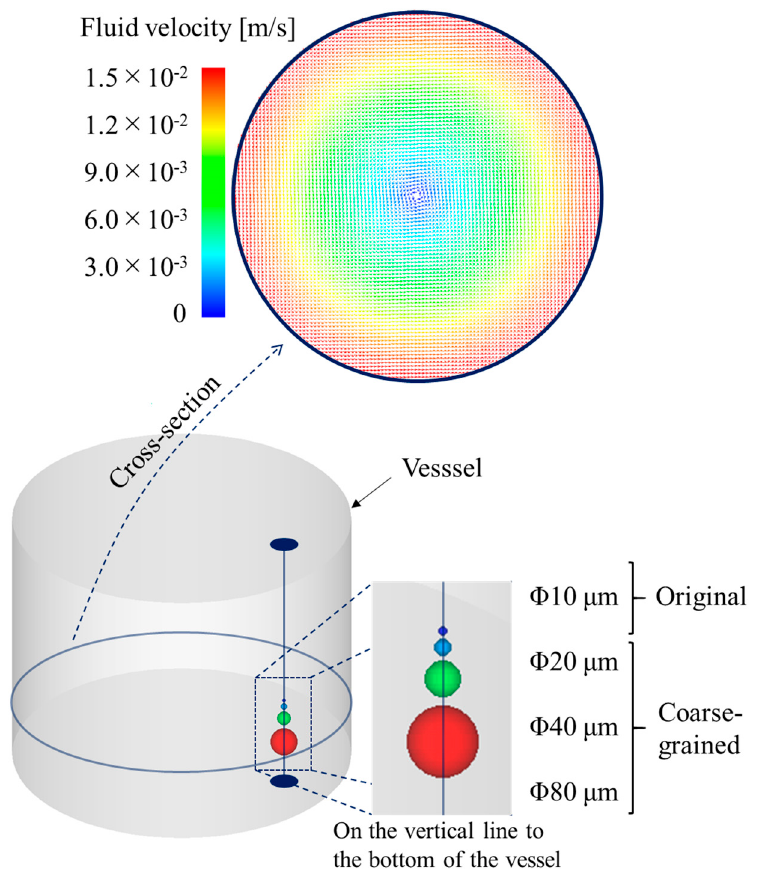
Figure 4. Initial positions of the original and the CG particles and schematic diagram of vortex flow field.